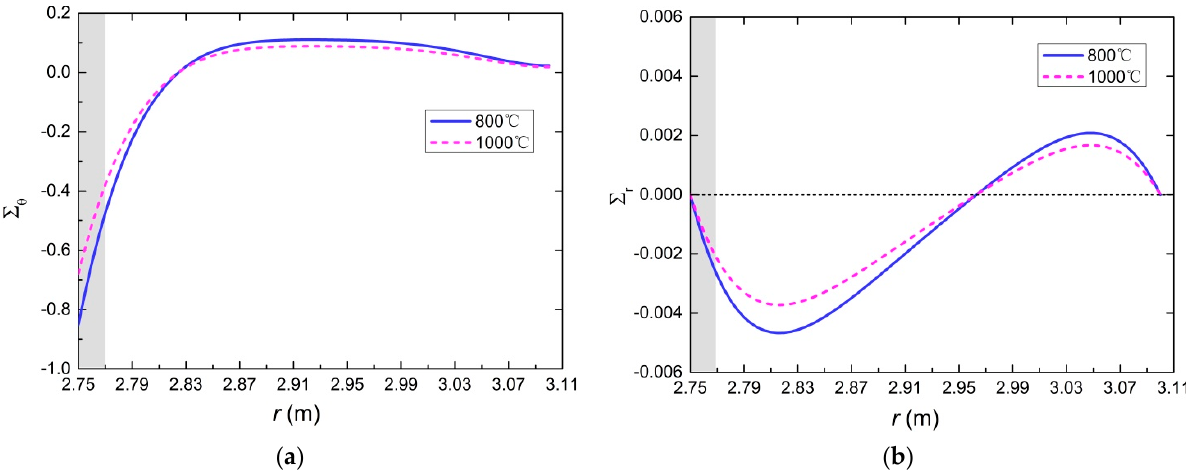
Figure 14. Dimensionless radial stress and circumferential stress at the spalling moment: ( a ) dimensionless circumferential stress; ( b ) dimensionless radial stress.